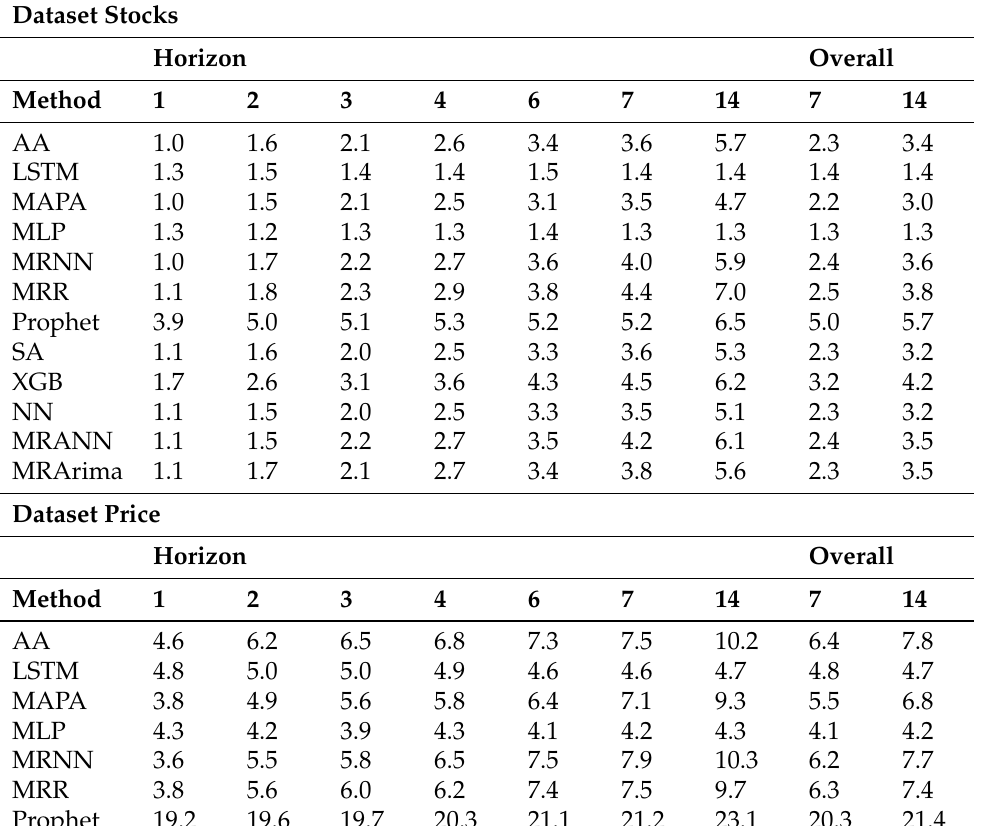
Table A4. Median SMAPE of multi-step forecasts from Prophet, MAPA, the two multiresolution forecasting methods MRR using regression and MRNN using a neural network, seasonal adapted ARIMA (SA), automatized ARIMA (AA), multilayer perceptron (MLP), long short-term memory (LSTM) and gradient boosting machine (XGB) for different horizons and for the median over horizons from 1 to 7 and 1 to 14. The forecasting techniques denoted with a start (*) did yield a non-significant result for unimodal distributions Hartigans’ dip test with Bonferroni correction meaning that oth- erwise the distribution is assumed to be non-unimodal. All Hartigans’ Test in this table yielded non-significant